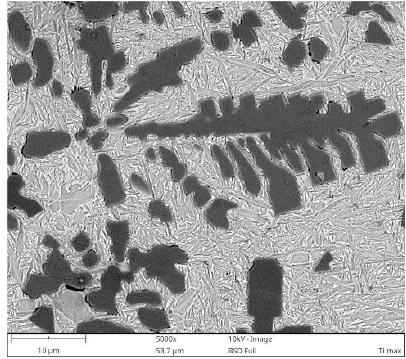
Figure 13. BSE SEM micrograph taken from the TRL region processed with pure Ti containing approximately 12.5 wt% Ti.